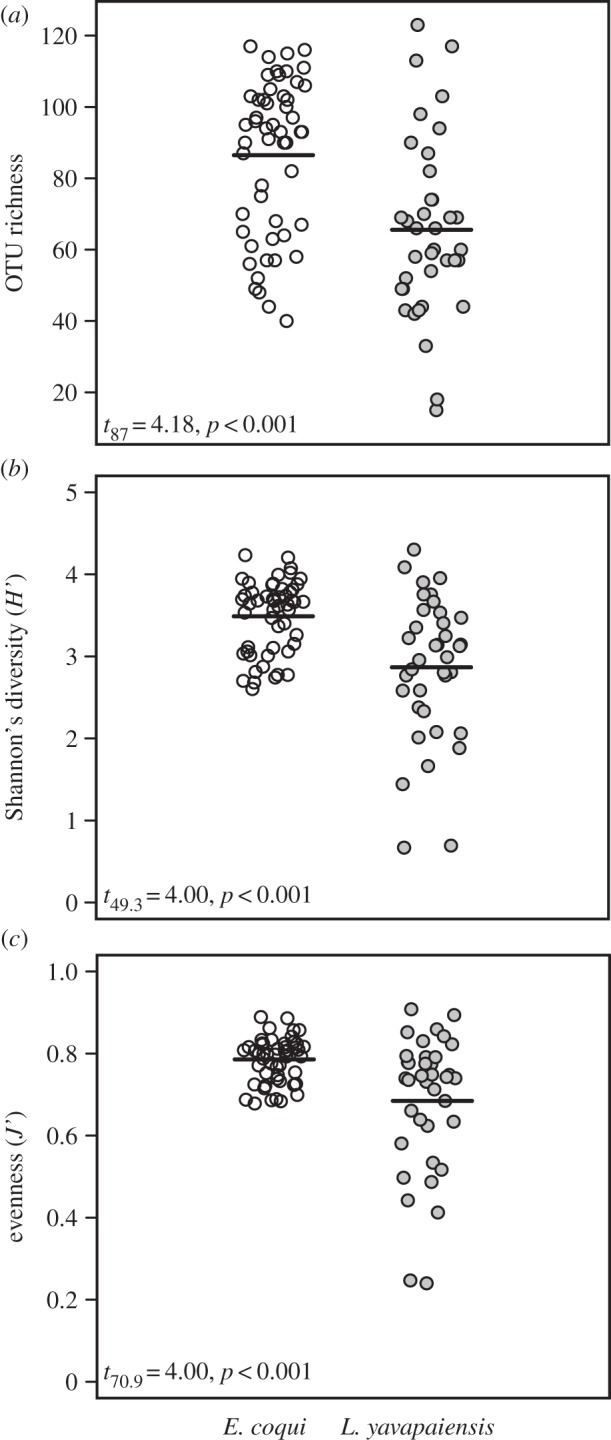
Mean interspecific differences in alpha diversity estimated by ARISA in E. coqui (open circles) and L. yavapaiensis (grey circles). (a) OTU richness, (b) Shannon's diversity and (c) Pielou's evenness.